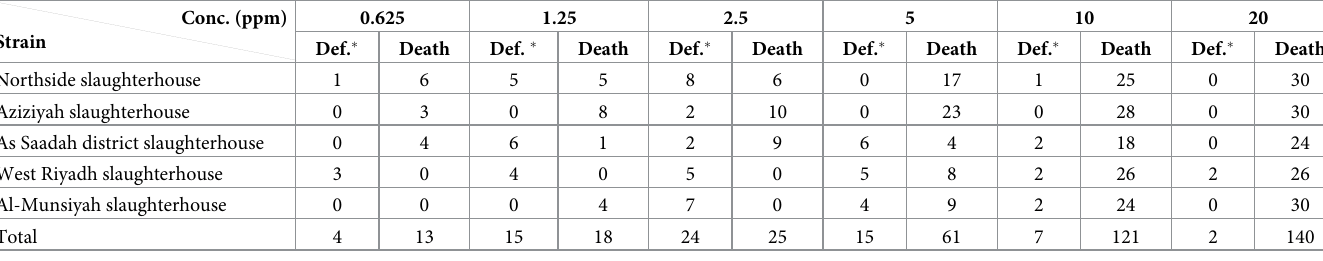
Table 2. Number of deformity cases induced by triflumuron at each concentration. Conc. (ppm)